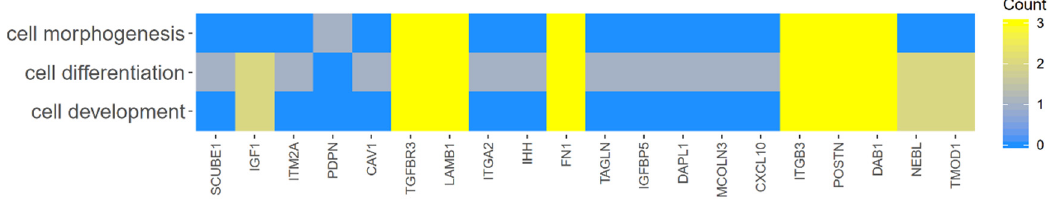
Figure 4. The representation of the mutual relationship between 10 most upregulated and 10 most downregulated genes that belongs to “cell development”, “cell differentiation” and “cell morphogenesis” GO BP terms. The ribbons indicate which gene belongs to which categories. The genes were sorted by logFC from most to least changed gene, with the most upregulated genes presented topmost and the most downregulated genes located at the bottom of the figure. The tips of the ribbons present the direction of the change (upregulation-green; downregulation-red), with each of their parts showing change in particular culture period (innermost—48 h/0 h; middle—96 h/0 h; outermost—144 h/0 h).